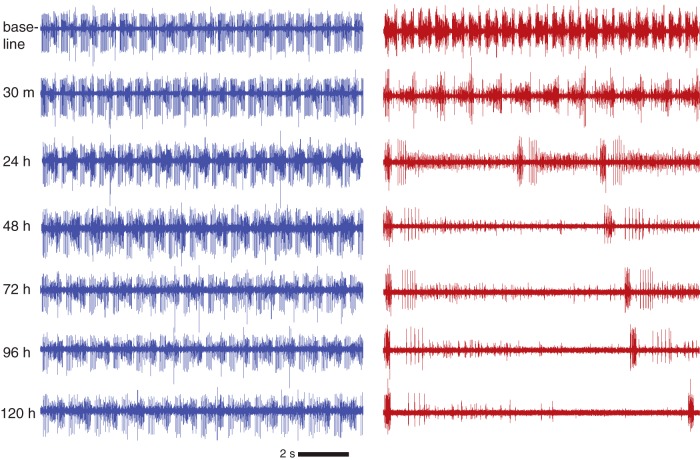
Long-term, continuous extracellular recordings of preparations of the STNS reveal stable behavior. Example 15 s lvn traces from two preparations, one in which with the stn left intact throughout the experiment (blue traces, left), and one in which the stn was transected shortly after the baseline recording (red traces, right).